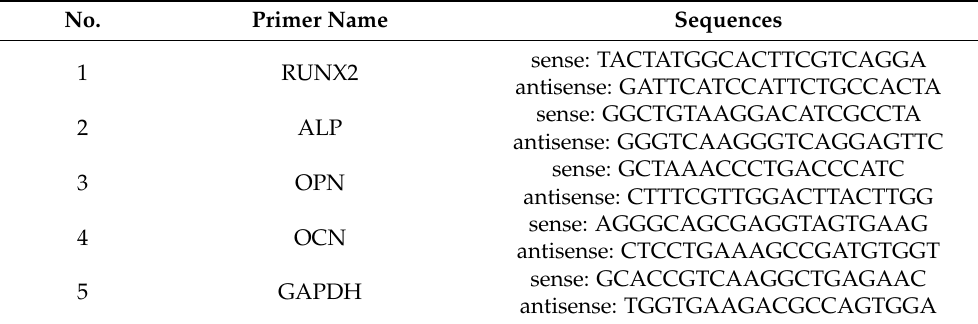
Table 1. The sequences of primers used for qRT-PCR